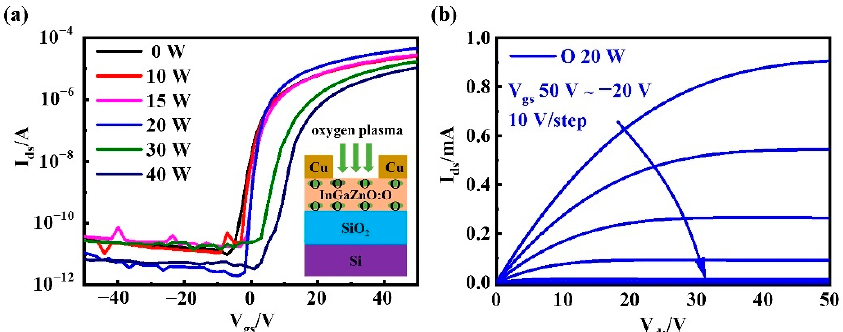
Figure 4. ( a ) Transfer characteristic curves of a-InGaZnO TFTs in the deposition state and a-InGaZnO TFTs in the active layer treated with oxygen plasma of different powers (inset is the cross section of a-InGaZnO:O TFTs); ( b ) Output characteristic curve of TFTs after a-InGaZnO active layer was treated with 20 W oxygen plasma power.